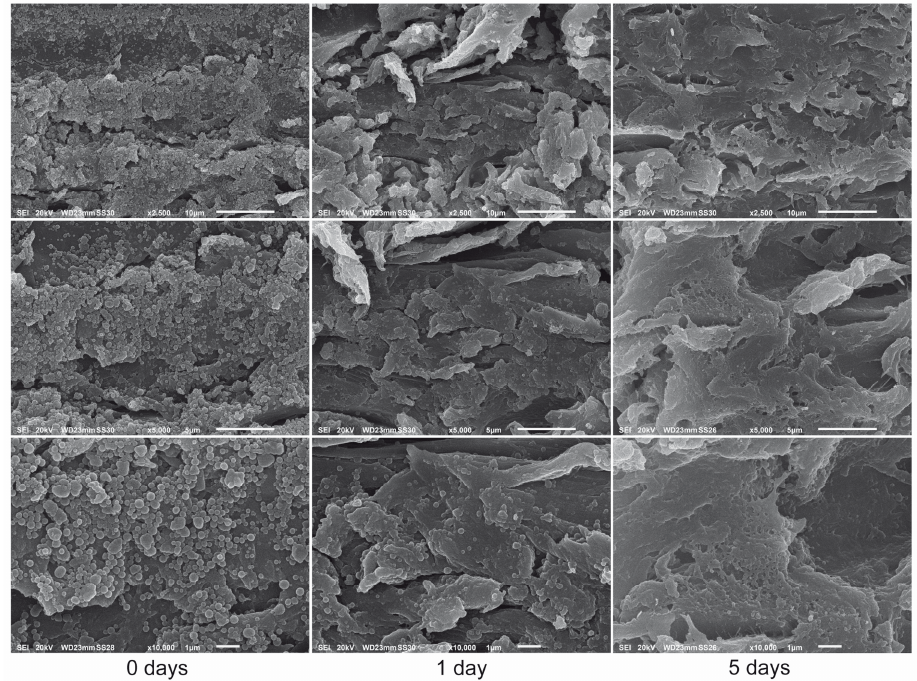
Figure 9. SEM micrographs of beech wood samples dip-coated with lignin nanoparticles from Iroko–Norway spruce mixed sawdust before, after 1 day and after 5 days of UV exposure in an accelerated weathering tester at different magnifications.